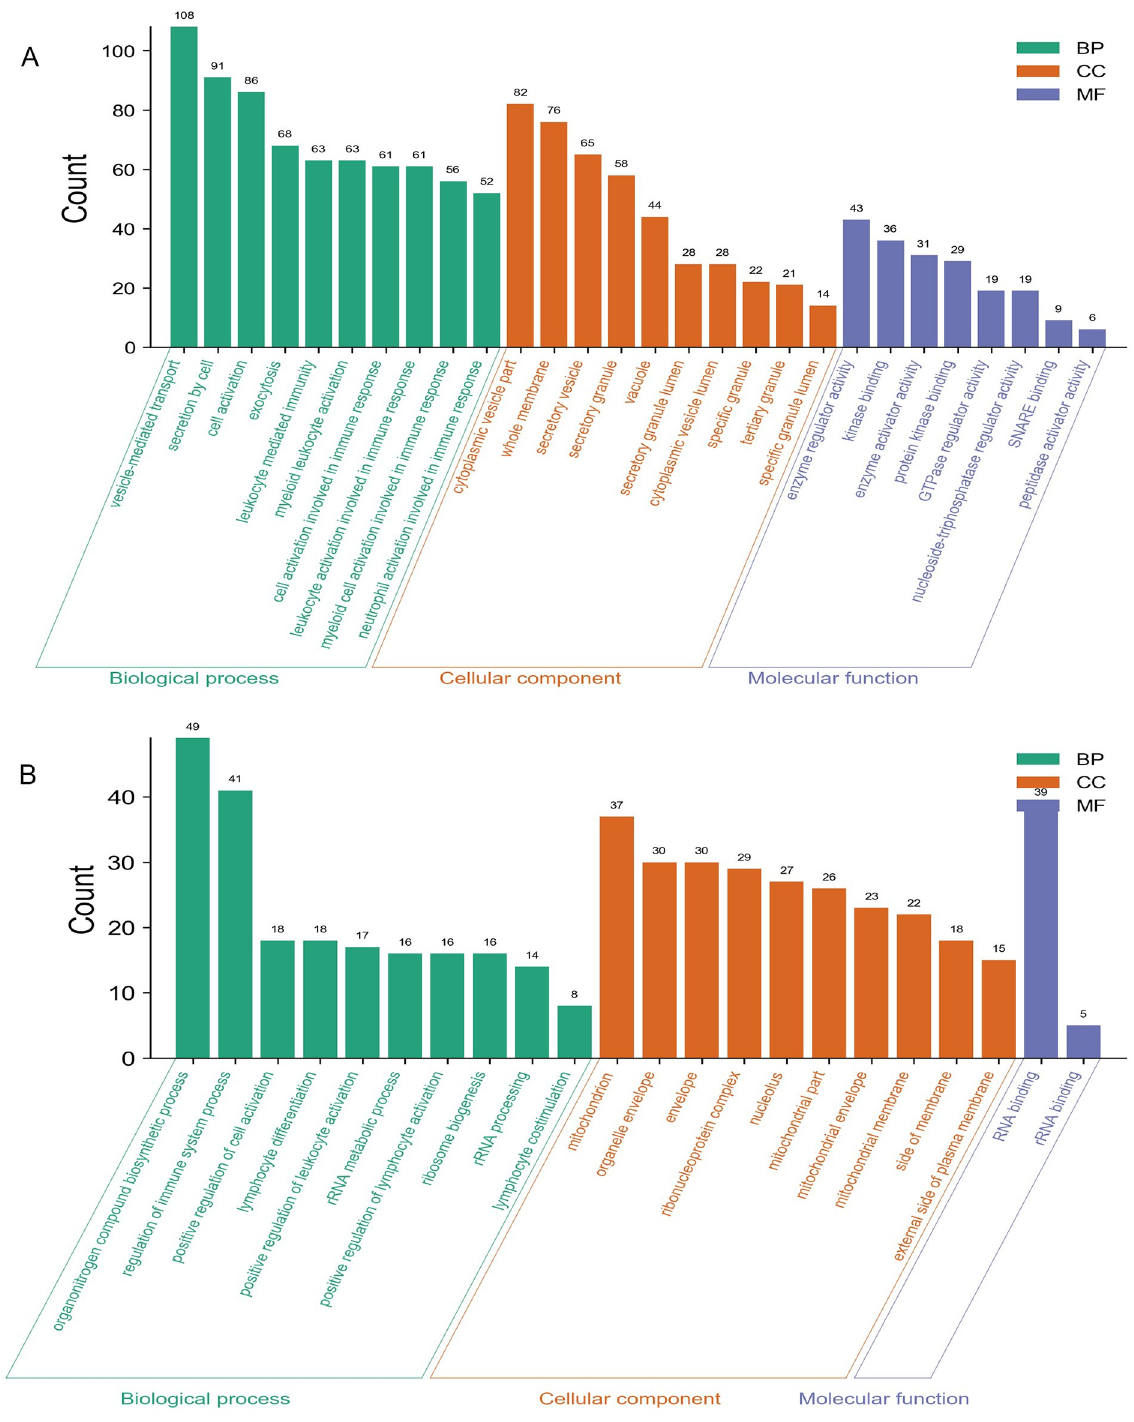
Fig 3. GO analyses of the female-specific upregulated (A) and downregulated (B). The y-axis depicts the number of genes. The x-axis lists the enriched functional terms. The color of bars corresponds to different categories of GO analysis (green represents BP, orange represents CC, and purple represents